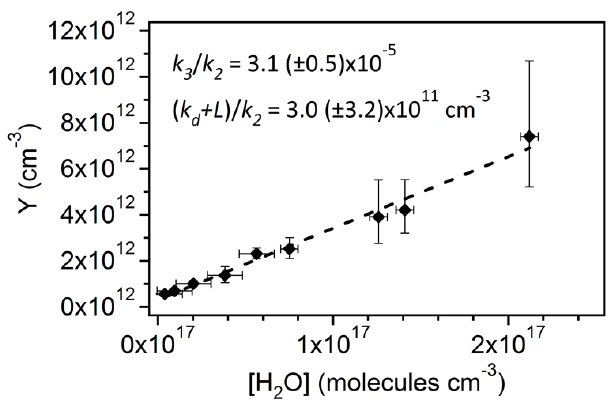
Figure 3. Application of Eq. (5) to derive relative rate constants for reaction of the isoprene-derived SCIs with H 2 O ( k 3 /k 2 ) and decomposition (( k d + L)/k 2 ) . Y = [SO 2 ] (( 1 /f ) − 1 ) − k 9 [acid] /k 2 .